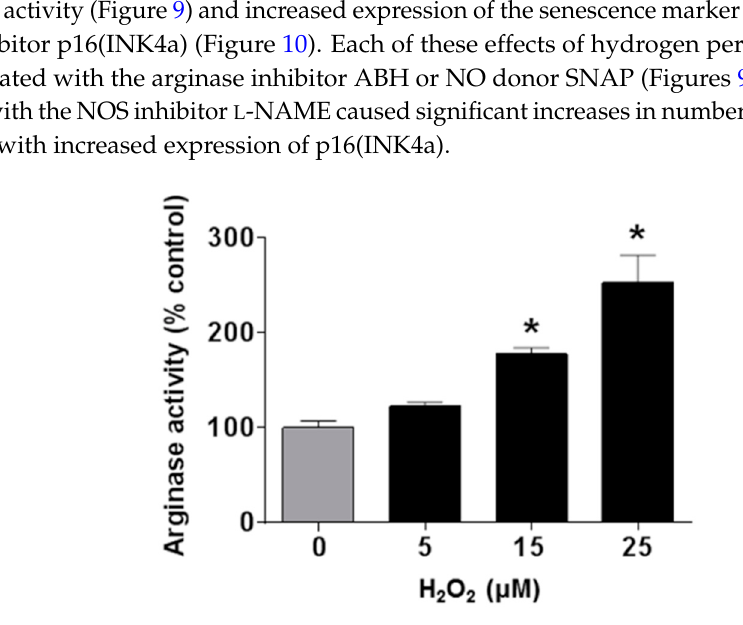
Figure 9. Hydrogen peroxide induces an increase in SA- β -gal activity. Treatment of retinal endothelial cells with hydrogen peroxide or the NOS inhibitor L -NG-nitroarginine methyl ester ( L -NAME) induced a significant increase in SA- β -gal activity (arrows). Treatment with the arginase inhibitor ABH blocked the hydrogen peroxide effect and treatment with the NO donor SNAP blocked the L-NAME effect. * p < 0.05 vs. control, n = 17. Scale bar = 30 µm.